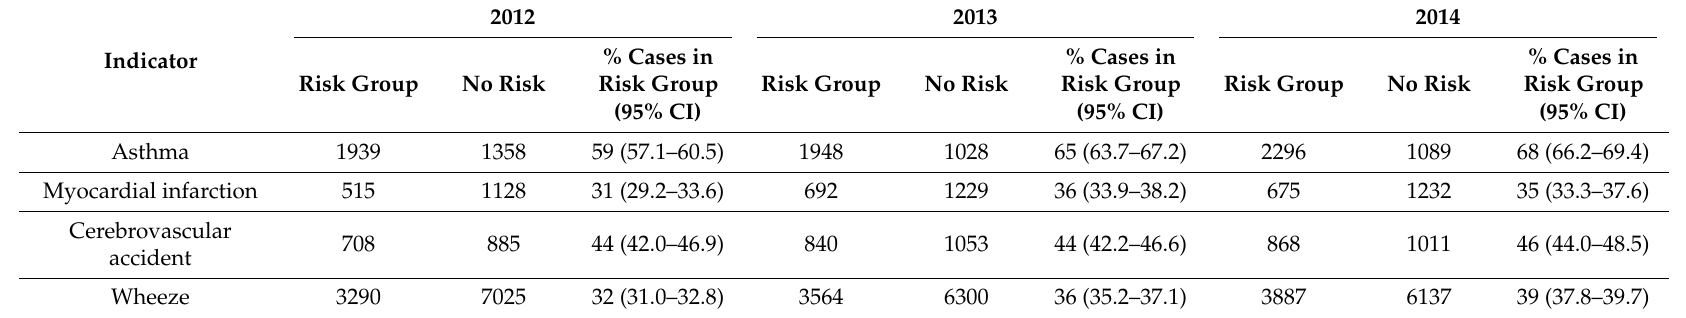
Table 3. GPIH syndromic indicators by risk group (as % of all cases) for the period 1 June to 15 September in the years